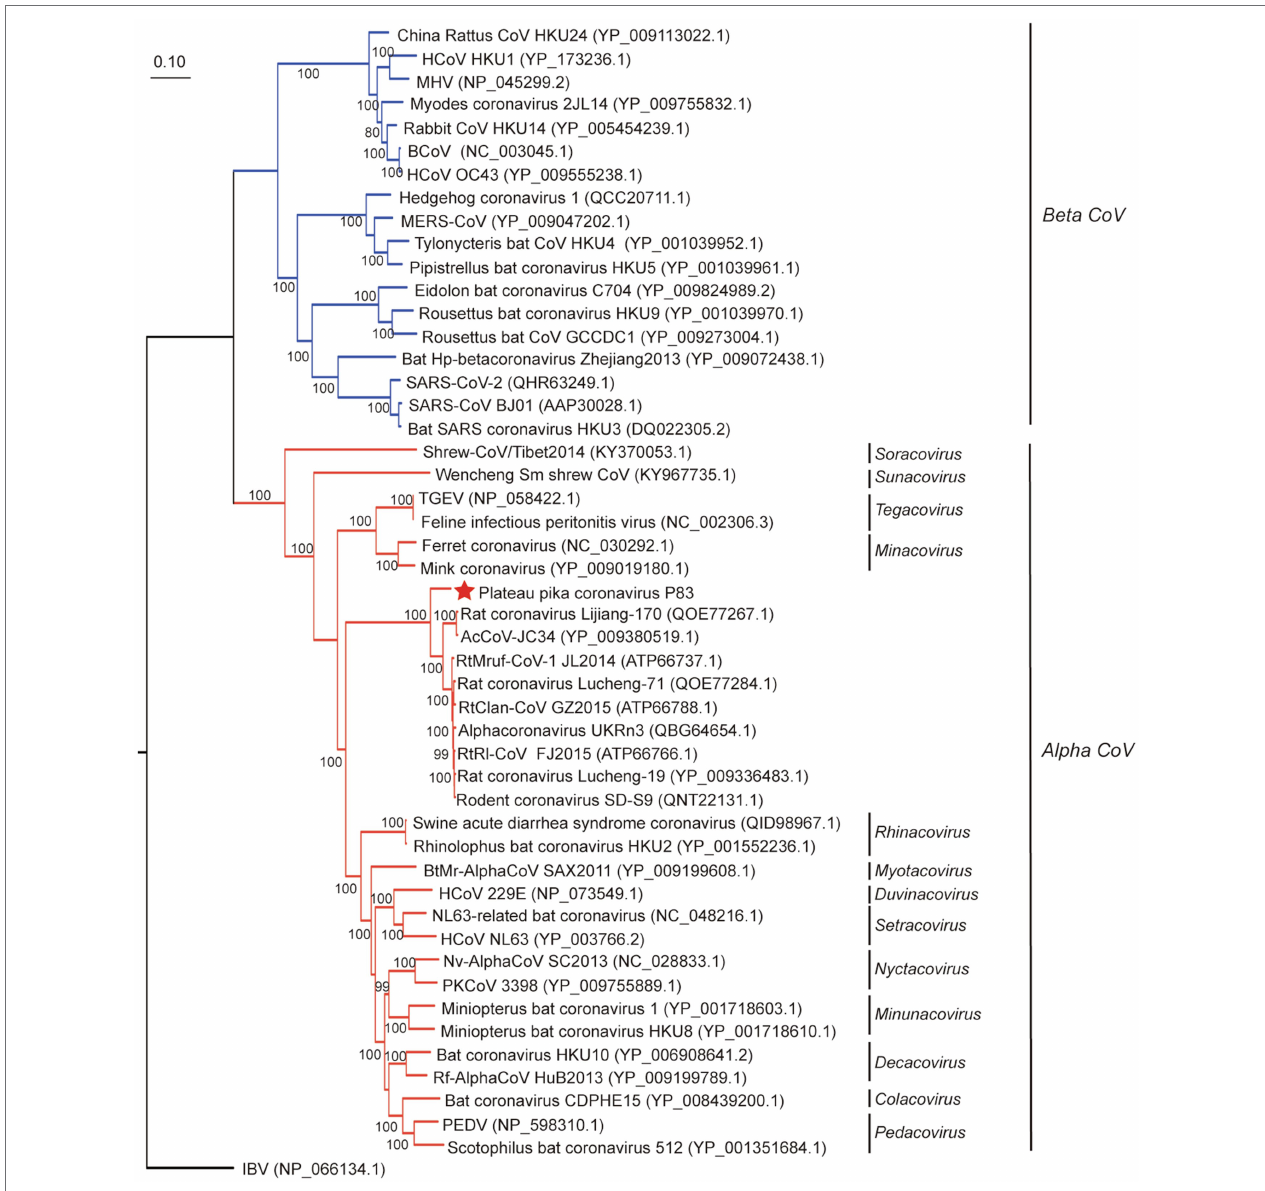
FIGURE 2 | Phylogenetic analysis based on amino acid sequences of ORF1ab. The tree was built by maximum-likelihood method with Dayhoff model and bootstrap values calculated from 1,000 trees. Only bootstrap values >80% are shown. Virus from this study is labeled with a red star. HCoV, human coronavirus; MHV, mouse hepatitis virus; BCoV, bovine coronavirus; MERS-CoV, MERS coronavirus; SARS-CoV, SARS coronavirus; TGEV, porcine transmissible gastroenteritis virus; RtMruf-CoV-1/JL2014, Rodent coronavirus isolate RtMruf-CoV-1/JL2014; RtRl-CoV/FJ2015, Rodent coronavirus isolate RtRl-CoV/FJ2015; AcCoV-JC34, Coronavirus AcCoV-JC34; PKCoV, Alphacoronavirus Bat-CoV/P.kuhlii/Italy/3398; PEDV, Porcine epidemic diarrhea